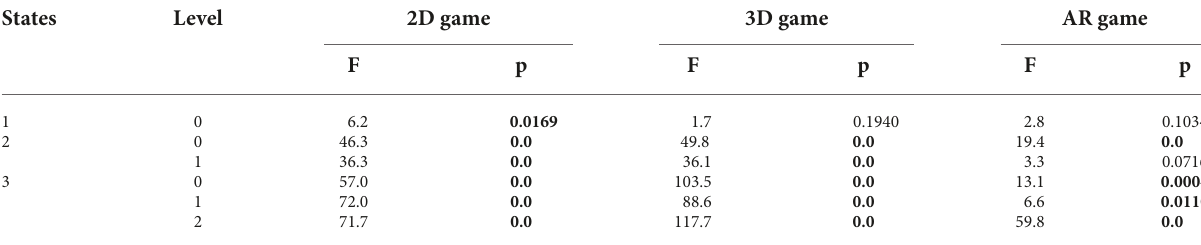
TABLE 2 ANOVA effect of the current and the previous state in the reaction time.